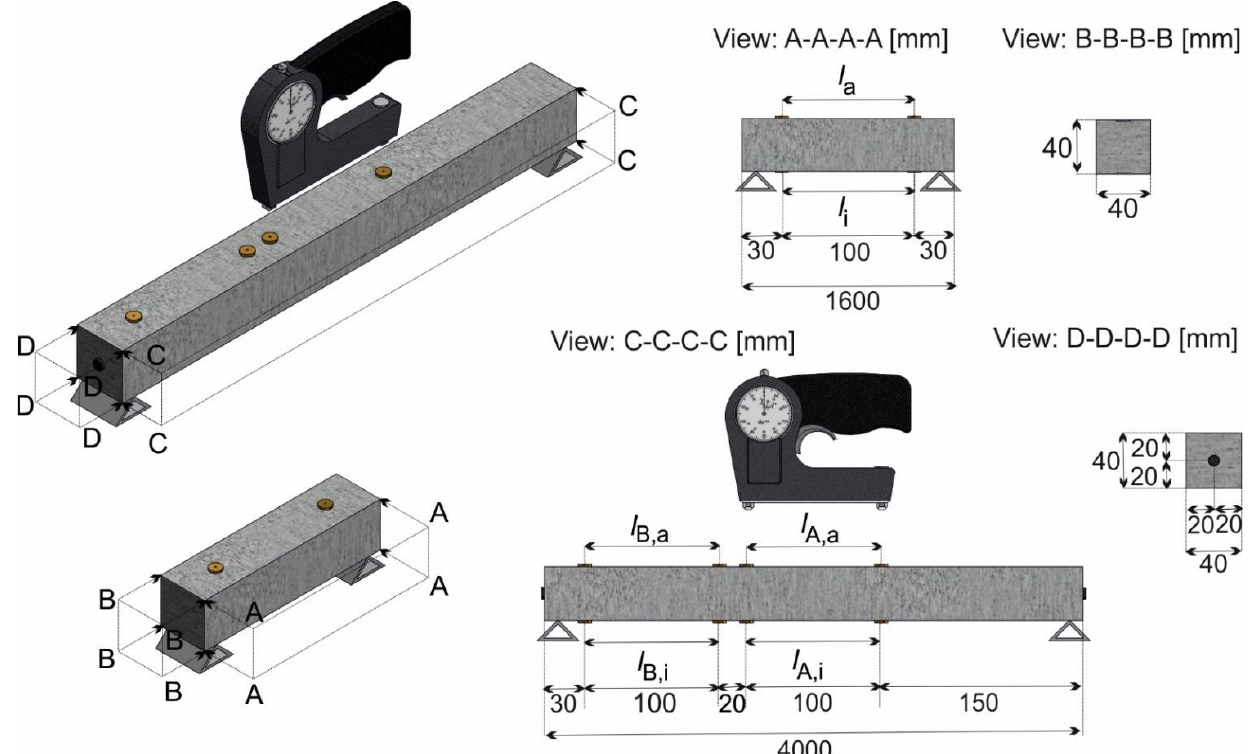
Figure 2. Experimental set-up for the shrinkage measurement.